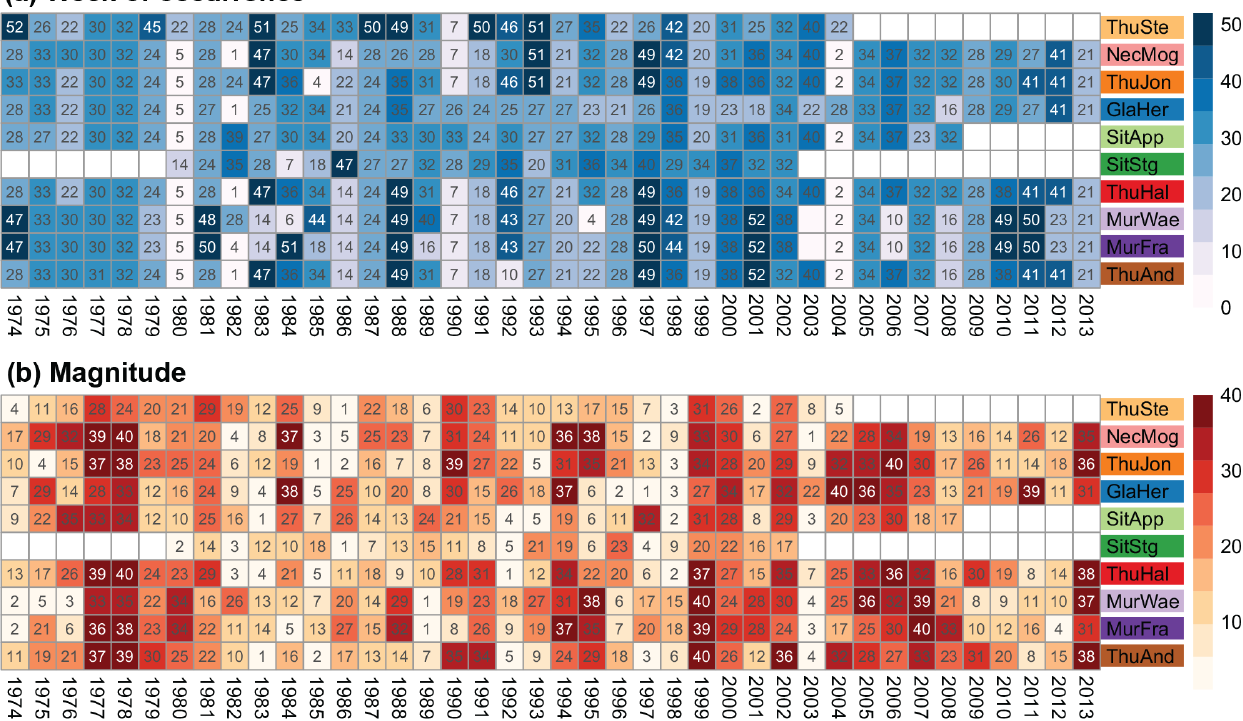
Figure 5. Heatplots of the week of occurrence (a) and the magnitude (b) of annual maxima of the 10 stations within the study area. The darker the color, the higher the ranks. Missing records lead to empty, white